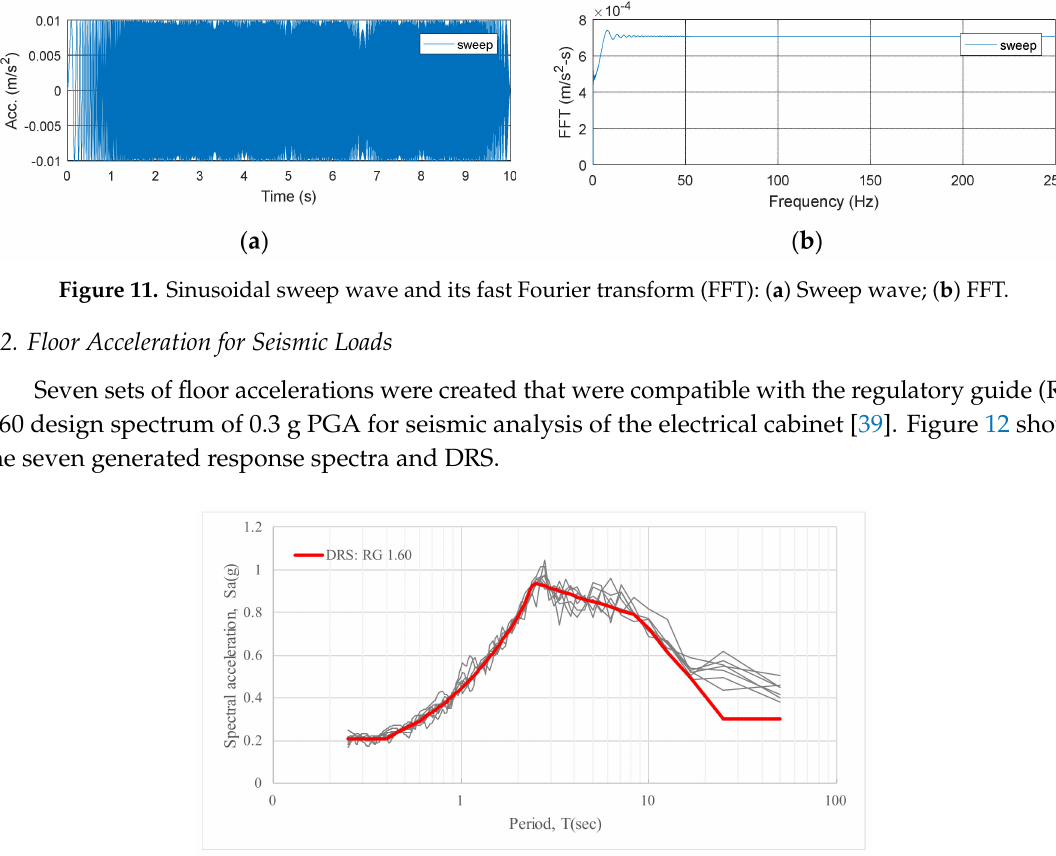
Figure 12. Horizontal design response spectrum (DRS) of RG 1.60 spectrum (5% damping).